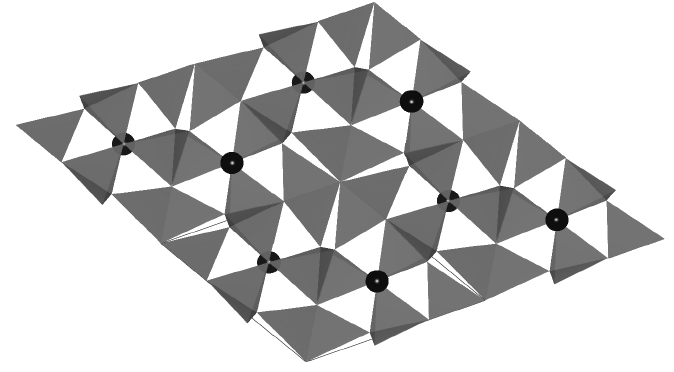
Figure 1. The crystal structure of Ca- α -sialon viewed from [001].The black balls represent the Ca